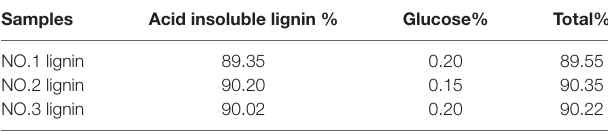
Table 2 | Chemical composition of three lignin samples.